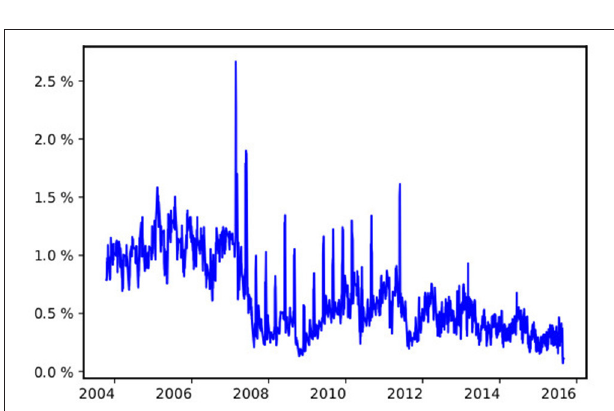
FIGURE 11 | The time series ( β t / K var, t ) t estimate K var, t